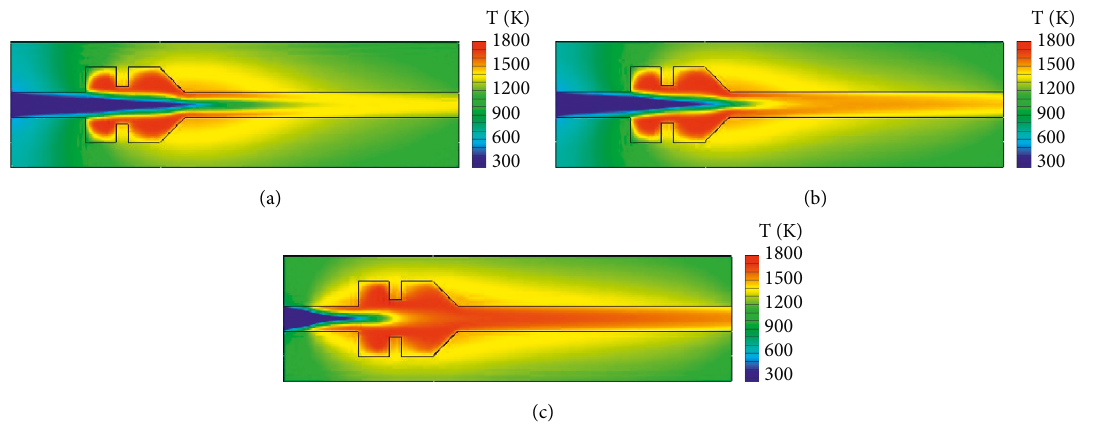
Figure 11: Temperature distribution of the improved microcombustor at equivalence ratios: (a) Φ � 0.4, (b) Φ � 0.5, and (c) Φ � 0.6.